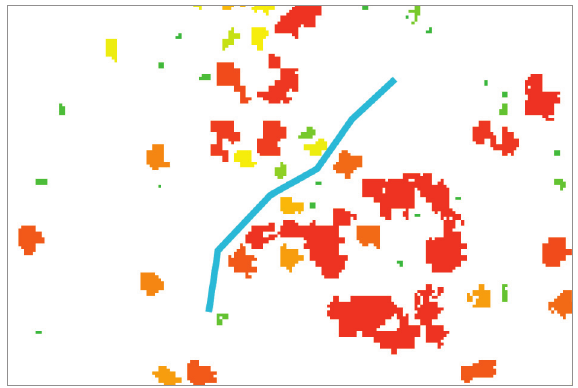
Figure 8: Trajectory map of cluster center for optimized routes.